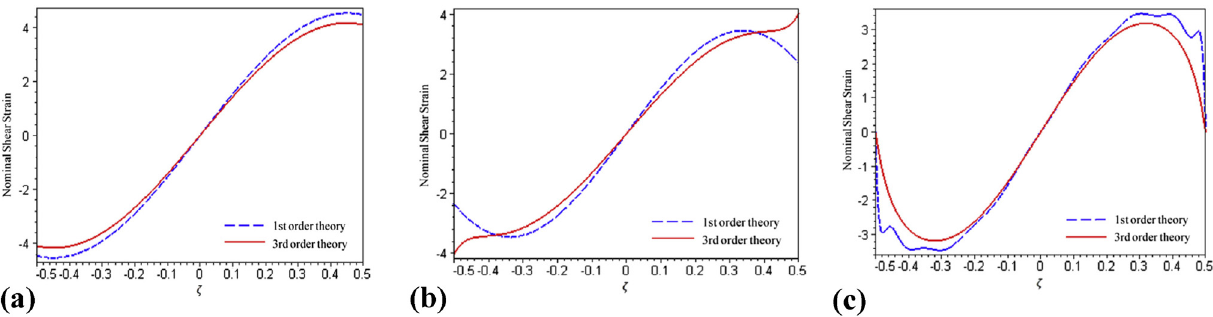
Figure 5: Nominal shear strains ζ along the FG - CNT beam in di ff erent boundary with V tcnt = 0.17 and L / h = 10 [ 90 ] . ( a ) P – P (